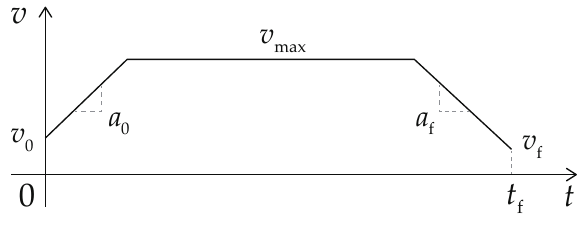
Figure 9. The trapezoidal profile of the longitudinal velocity.